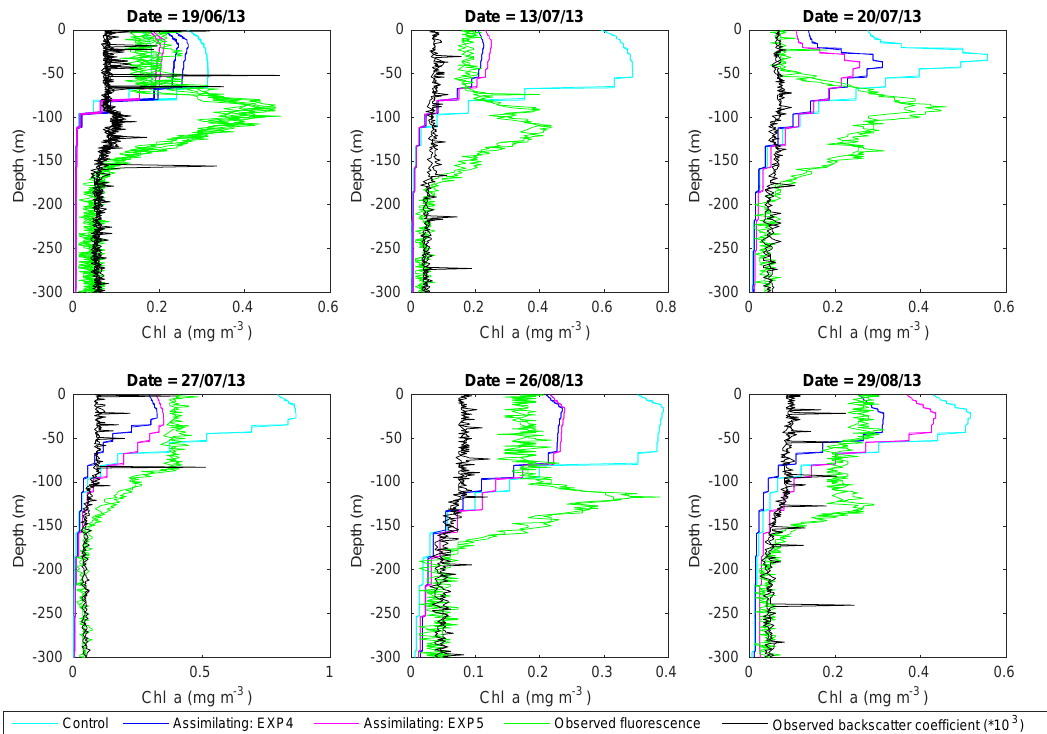
Figure 8. Comparison of depth-resolved Chl a against six individual glider profiles using the method described in the caption of Fig. 7. Glider observations of Chl a and backscatter coefficient are green and black respectively, the non-assimilating control run profiles are cyan and the assimilating run profiles for EXP4 are blue and EXP5 are